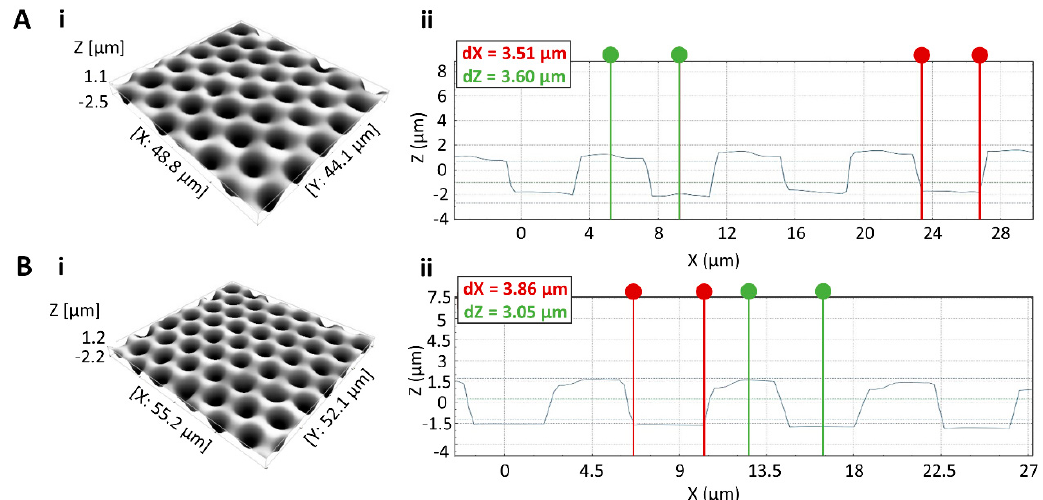
Figure 5. ( A ) Microwell array fabricated by molding (Procedure I). (i) 3D image of the microwell array, and (ii) 2D section of the molded microwell array with a well of 3.51 µ m in diameter (indicated in red) and another well of 3.60 µ m in depth (indicated in green). ( B ) Microwell array, fabricated by molding and subsequent plasma treatment (Procedure II). (i) 3D image of the microwell array, and (ii) 2D section of the microwell array after plasma treatment, resulting in removal of Teflon squeeze film from the bottom of the wells and minimally affecting the well geometry, with a diameter of 3.86 µ m (indicated in red) and depth of 3.05 µ m (indicated in green).